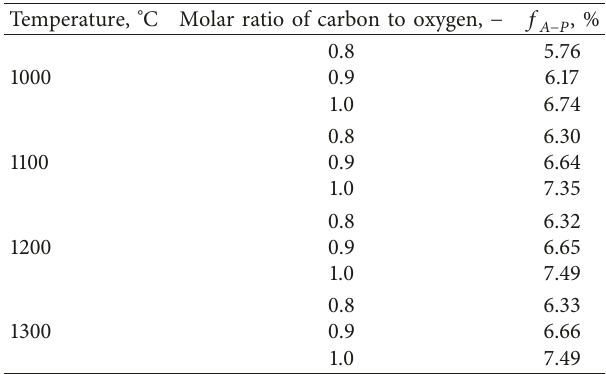
Table 4: f A − P value of carbon-containing alumina balls under different conditions